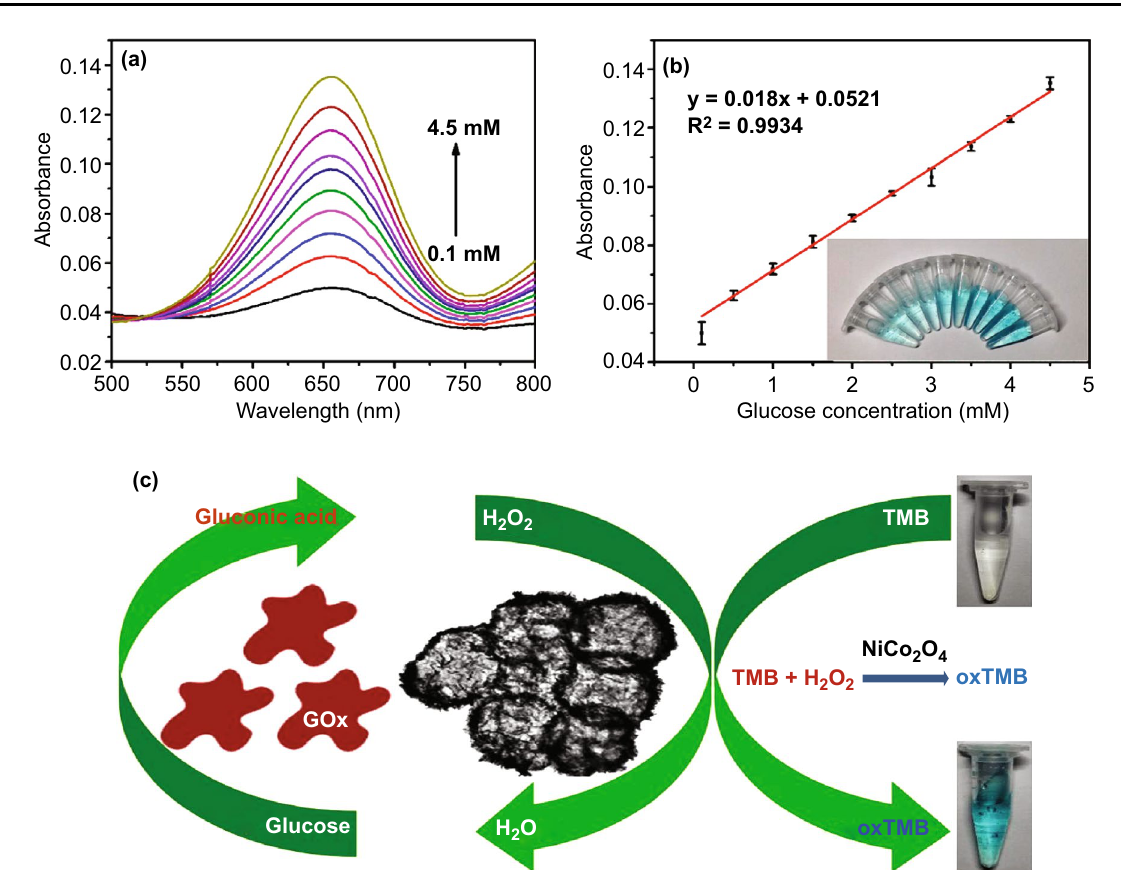
Fig. 30 a Effect of glucose concentrations on absorption. b Linearized calibration curve. c Proposed mechanism for colorimetric detection of glucose using the hierarchical NiCo 2 O 4 hollow sphere. Reproduced with permission from Ref. [274], Copyright © 2017 by the authors; licensee MDPI, Basel,